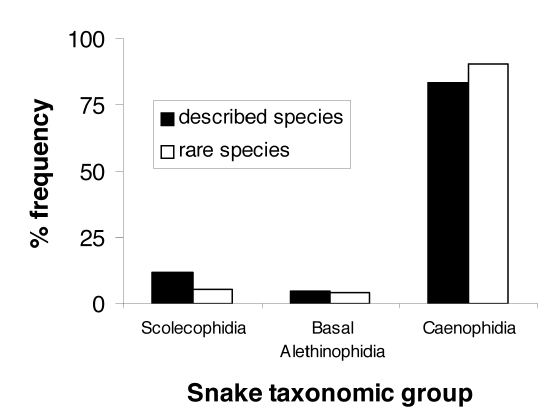
Fig. 4. Comparison between the percent frequency of occurrence of rare species (RAR + VER) in the reviewed literature (total n = 206) and the percentage of known species classified by family in relation to the total number of snake species (n = 2718), in the three broad taxonomic groups of snakes. Subdivision of snake families by broad taxonomic group follows Table 2. For the statis- tical details see the text.